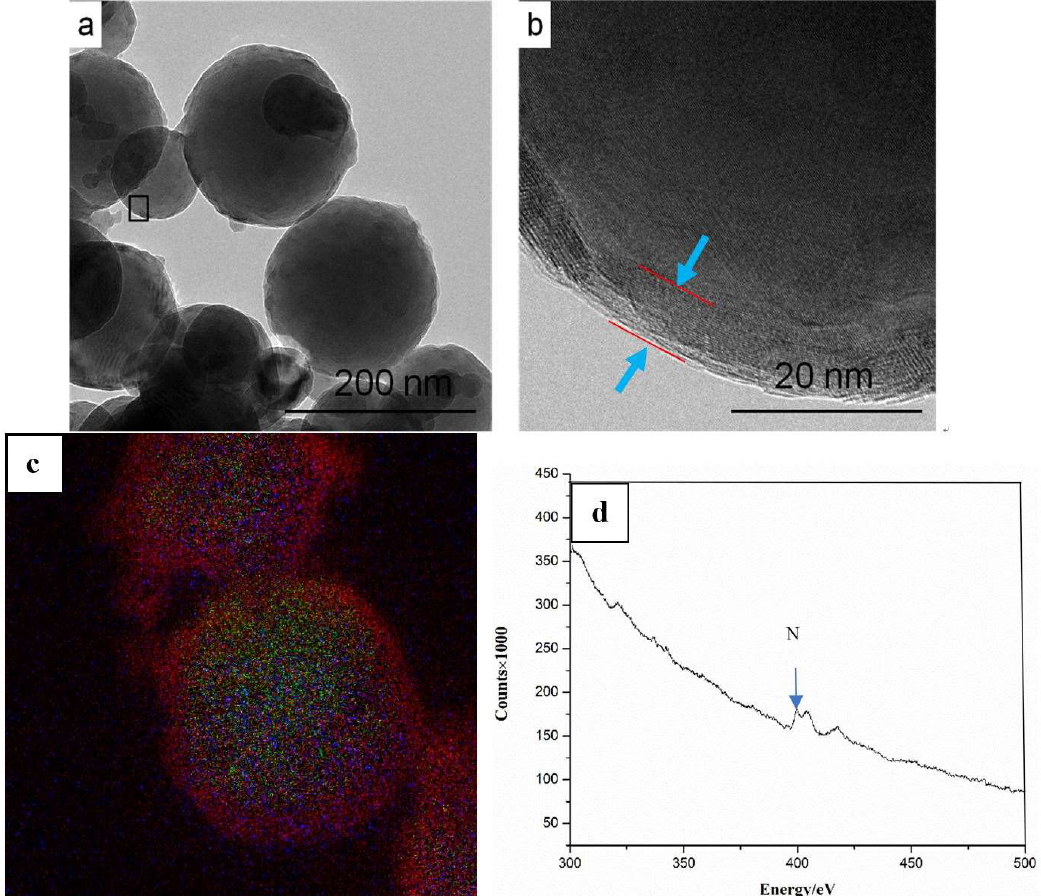
Figure 2. ( a ) Transmission electron microscopy (TEM) image of the aluminum nanoparticles (ANs) after surface nitridation at 550 °C, ( b ) TEM with higher resolution for segmental magnification, and ( c ) Surface elemental distribution with color indication: Al (red), N (green), and O (blue). Noting that a slight color aberration may be observed on a nanosphere structure due to the difference of trap depth energy of the TEM detection; ( d ) A peak at 401 eV characteristic of